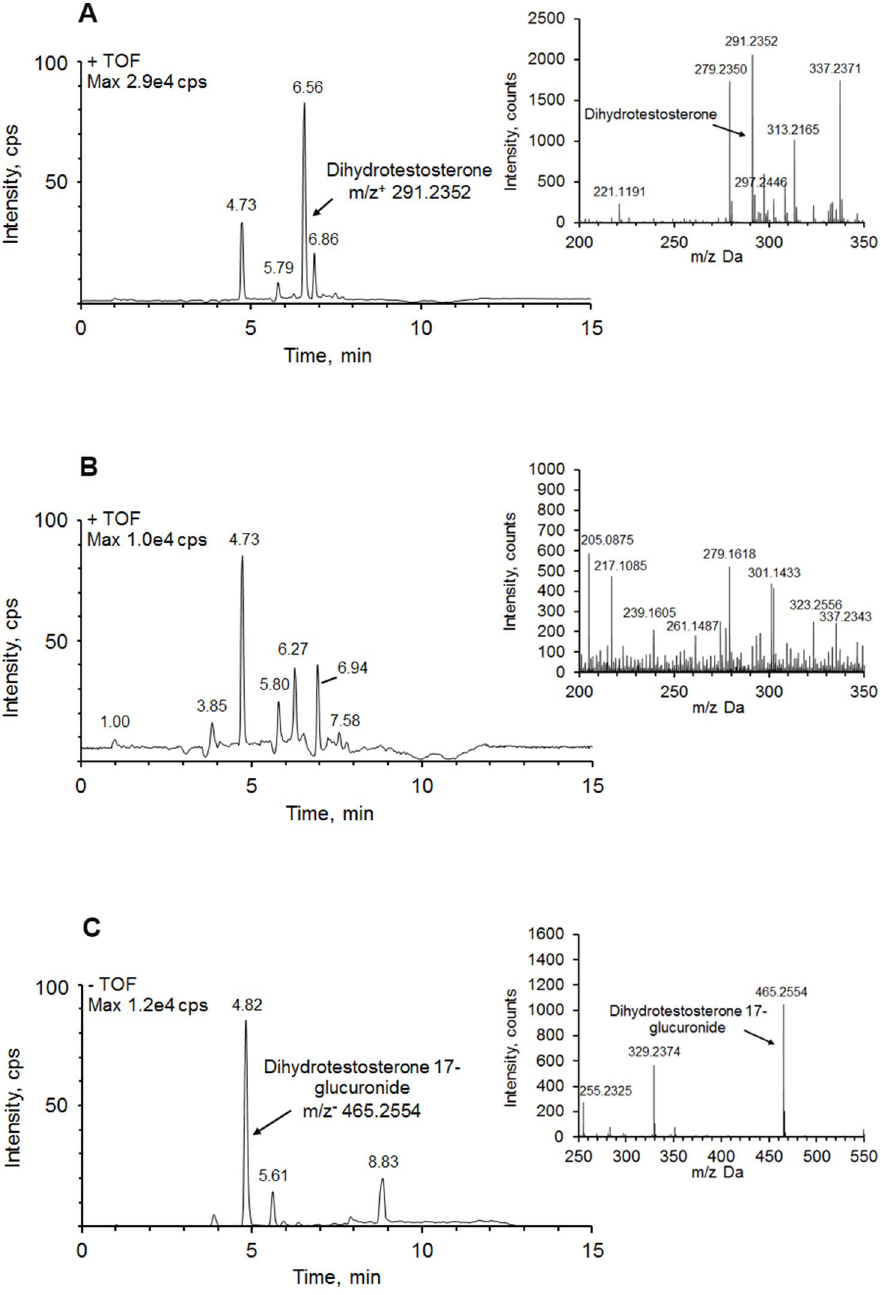
Figure 3. Ion chromatograms and mass spectra (inset) of dihydrotestosterone and its metabolite. ( A ) dihydrotestosterone in the medium in absence of isolated hepatocytes; ( B ) dihydrotestosterone in the medium in the presence of isolated hepatocytes. No dihydrotestosterone was found after 6 h of cell culture; ( C ) identified dihydrotestosterone metabolite dihydrotestosterone-17-glucuronide (m/z 2 =465.2554). The samples were analyzed in ESI– ionization mode.